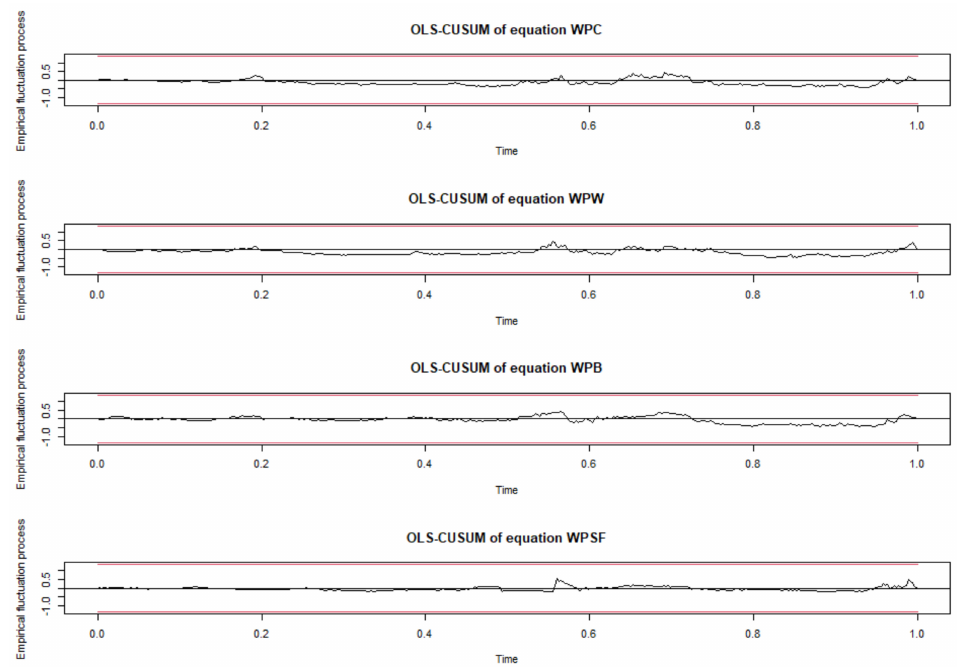
Figure A2. Structural breaks of four variables within the system.